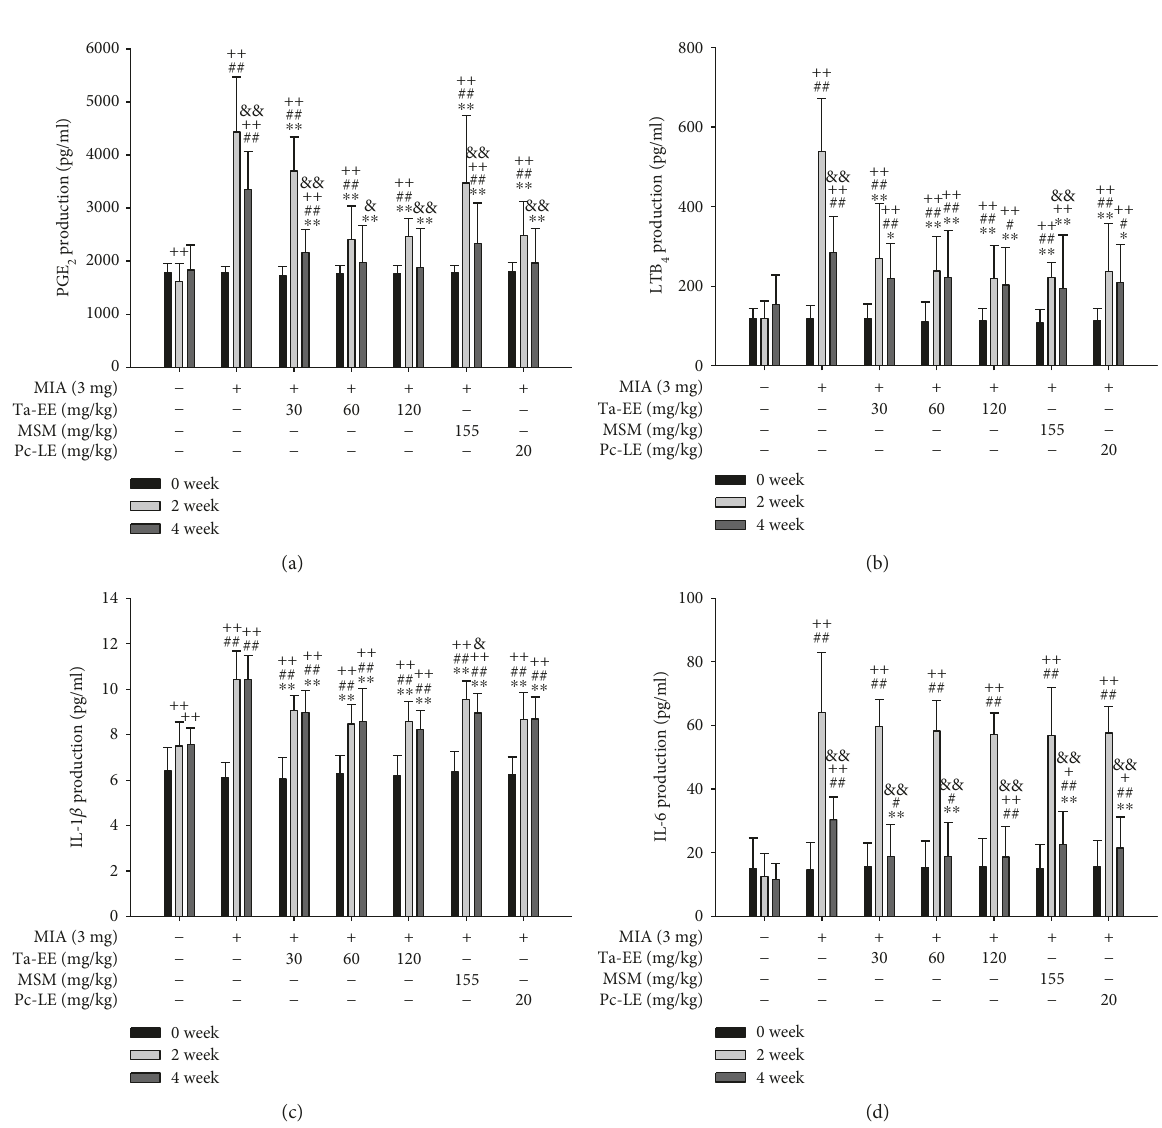
Figure 2: Ta-EE reduced the serum levels of in fl ammatory mediators and proin fl ammatory cytokines in MIA-induced OA rats. MIA-induced OA rats were orally administered with either Ta-EE (30 – 120mg/kg), MSM (155mg/kg), or Pc-LE (20 mg/kg) once a day, and the levels of (a) PGE , (b) LTB , (c) IL-1 β , and (d) IL-6 in the sera of the rats in each group were measured at weeks zero, two, and four. ∗ P < 0 05 , ∗∗ P < 0 005 2 4 versus a control group; # P < 0 05 and ## P < 0 005 versus a normal group; + P < 0 05 and ++ P < 0 005 week 0 versus week 2 or 4; & P < 0 05 and && P < 0 005 week 2 versus week